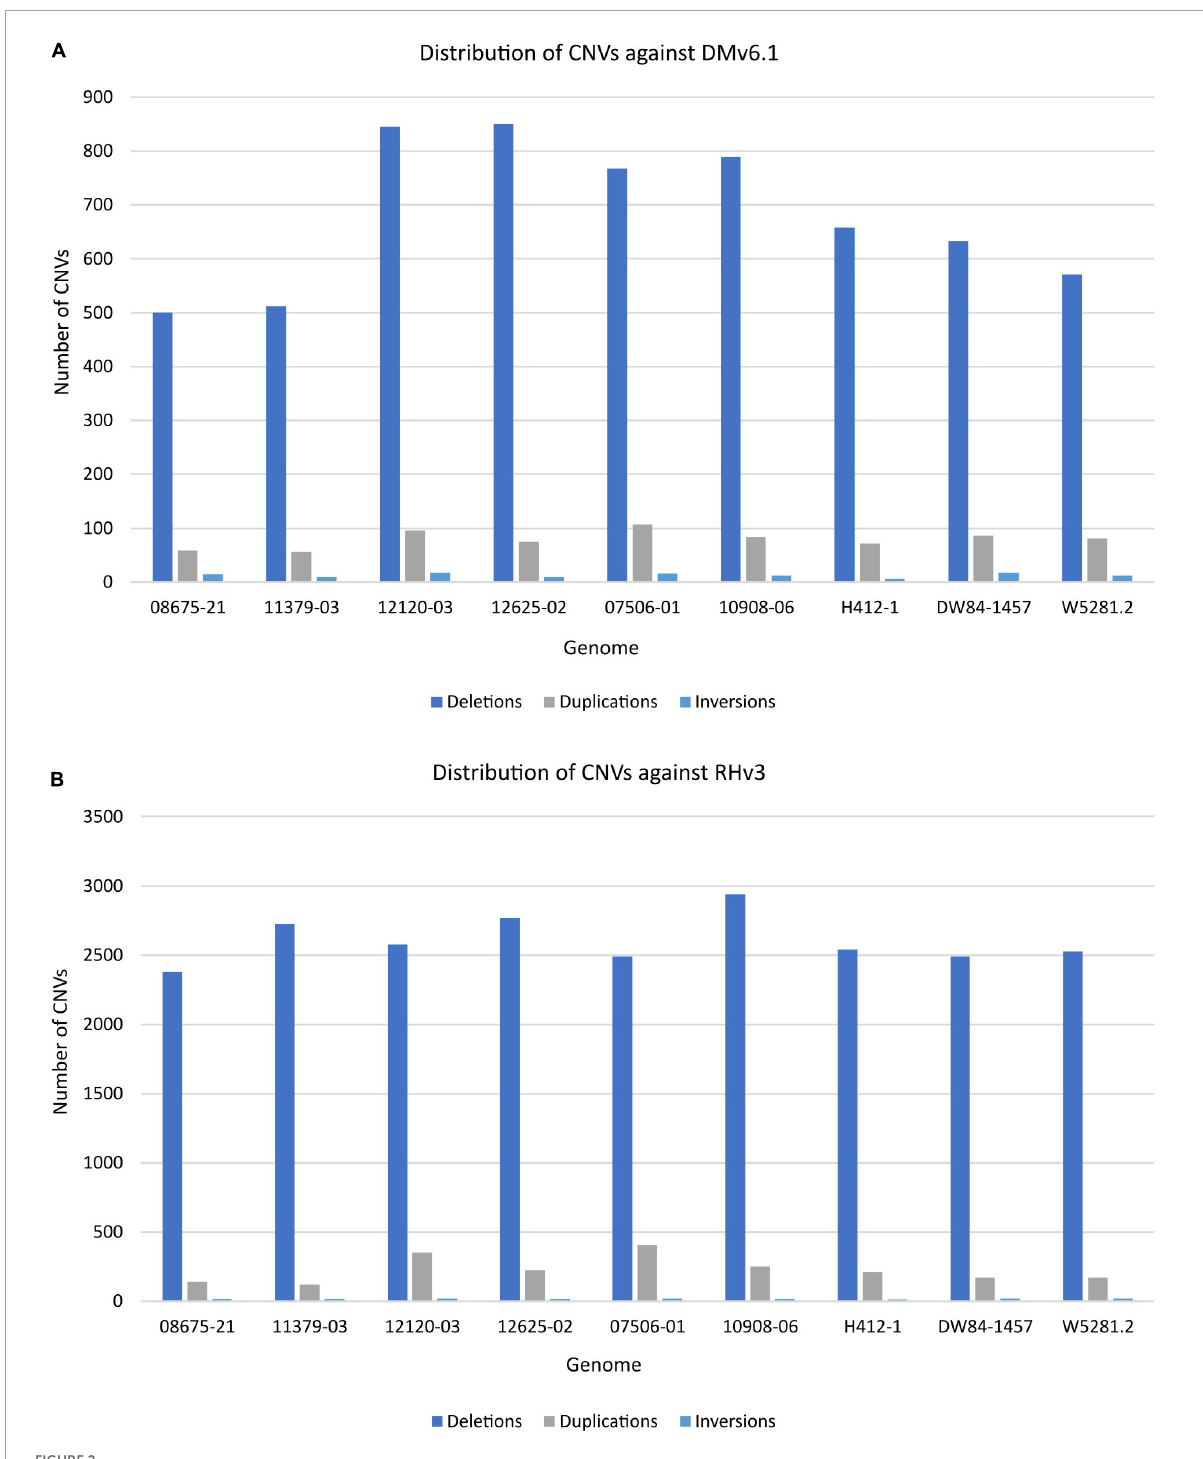
FIGURE2 Distribution of CNVs in each genome when compared against (A) DMv6.1 and (B) RHv3.